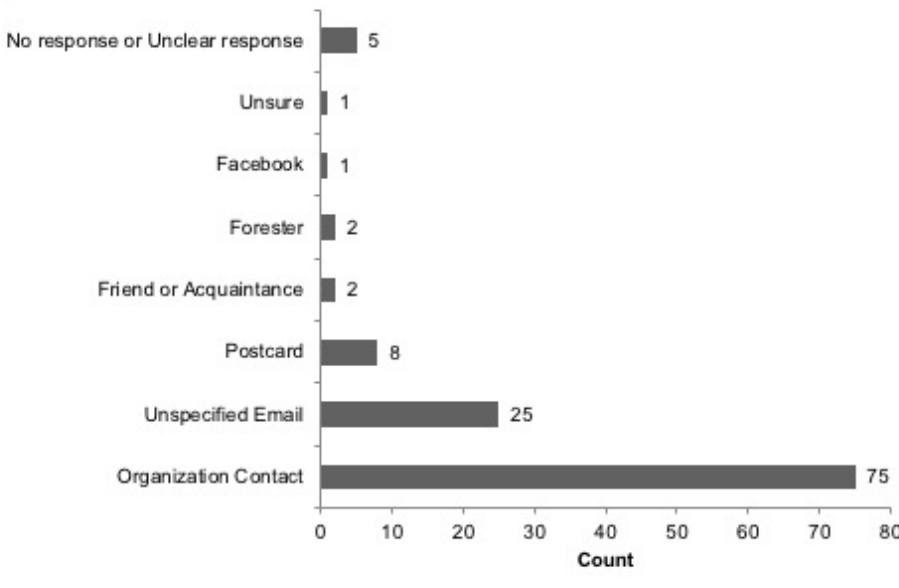
Figure 1. Recruitment channels for respondents.